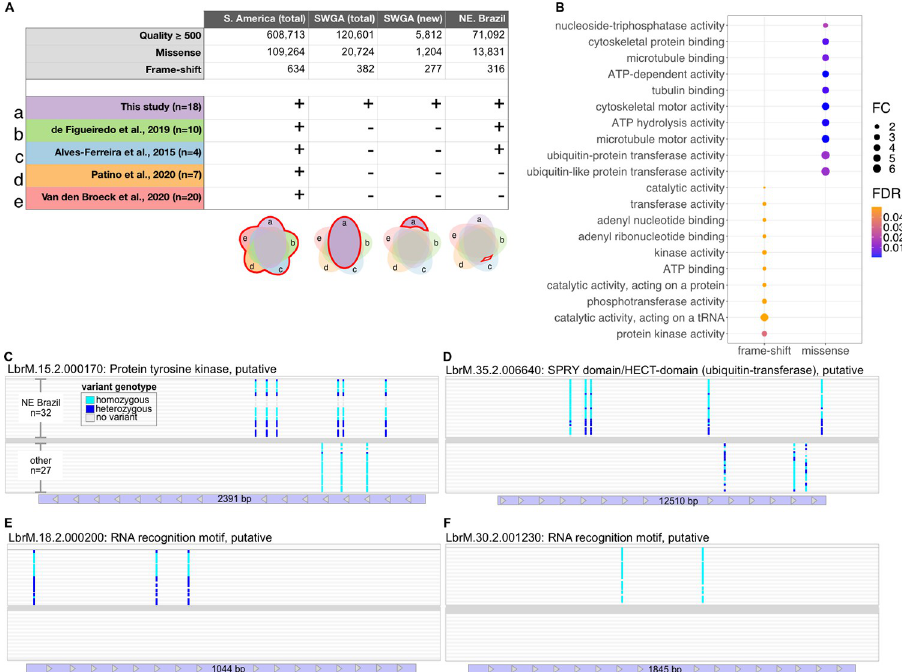
Fig 6. Identification of variants unique to Northeastern Brazil. (A) Table showing variants identified by integrated analysis of WGS and SWGA genomes (top), and studies included (+) or excluded (-) from the analysis (bottom). Venn diagrams indicate how each of the five studies (labeled a-d; [7, 46, 8, 47] ) were used in the integrated analysis to generate the variants shown in table column above. (B) Bubble chart showing results of Gene Ontology (GO) enrichment for Molecular Function terms associated with 149 genes containing frame-shift variants (left) or 152 genes identified with high-frequency missense mutations in Northeast (NE) Brazil (right). All terms shown were associated with � 5 genes. FC = fold change; FDR = false discovery rate (Benjamini-Hochberg correction). (C) Four representative parasite genes that were enriched for high-frequency missense mutations in genomes from Northeast